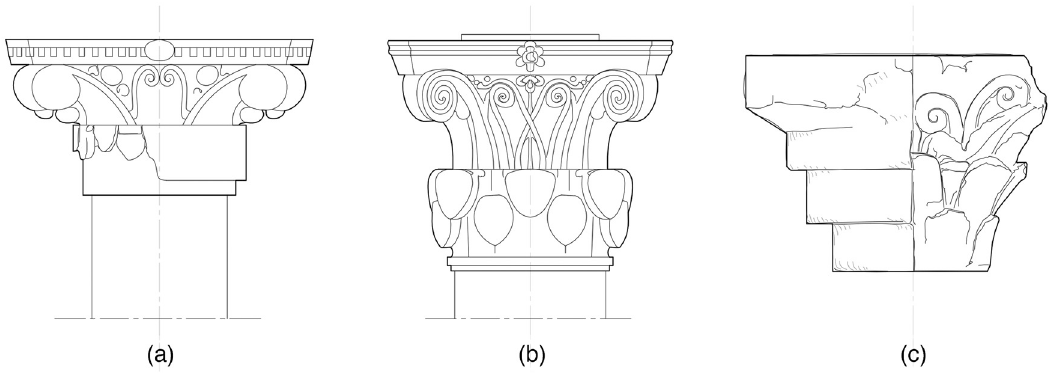
Figure 9: Selected un fi nished capitals: ( a ) Kom Ombo, ( b ) Dendera, and ( c ) Cherchell ( drawing: S. Pop ł awski, based on